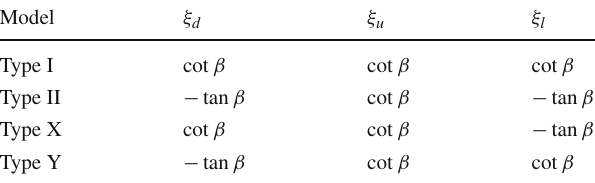
Table 2 Choices of the couplings ξ f for the four Yukawa models of 2HDM Model